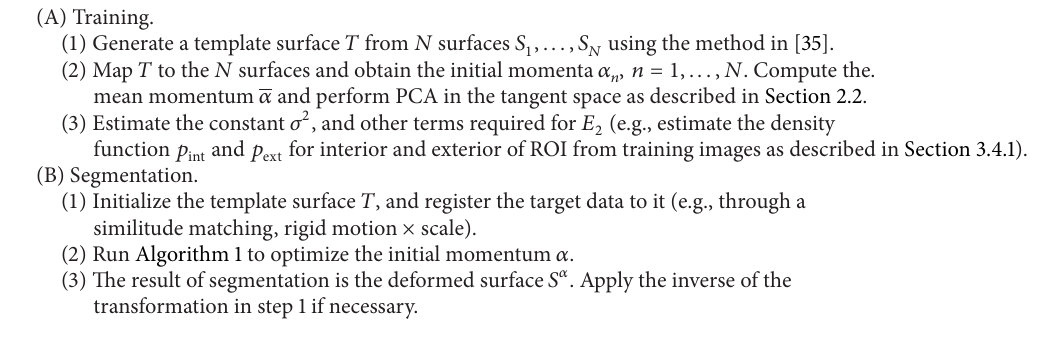
Algorithm 2: Geodesically controlled diffeomorphic active shapes.